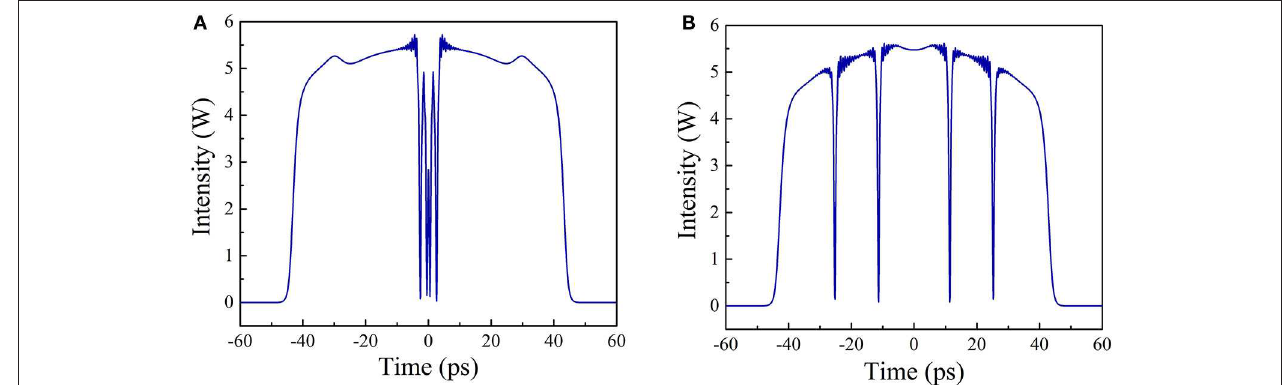
N = 115. As a consequence, the left and right parts of